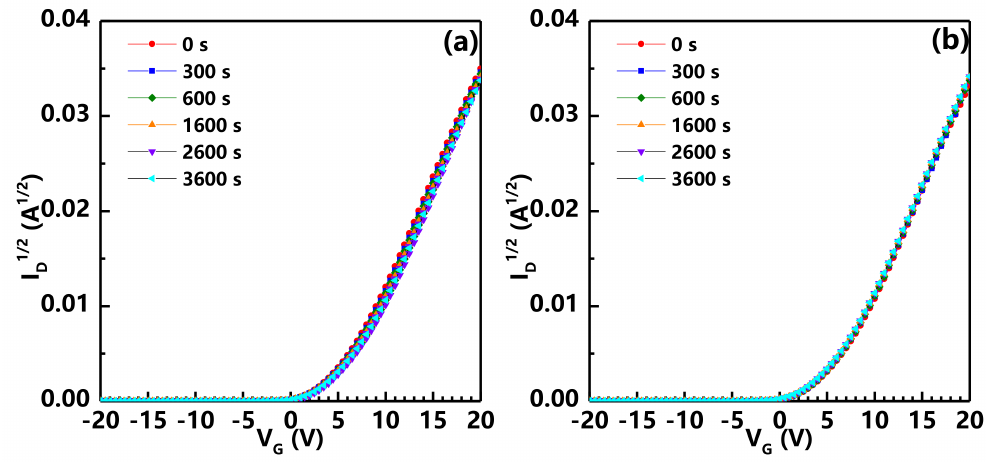
Figure 6. Variations of the transfer characteristics of a-IGZO TFT with Cu S/D and Al 2 O 3 PVL after post-annealing under ( a ) positive and ( b ) negative bias stress for 3600